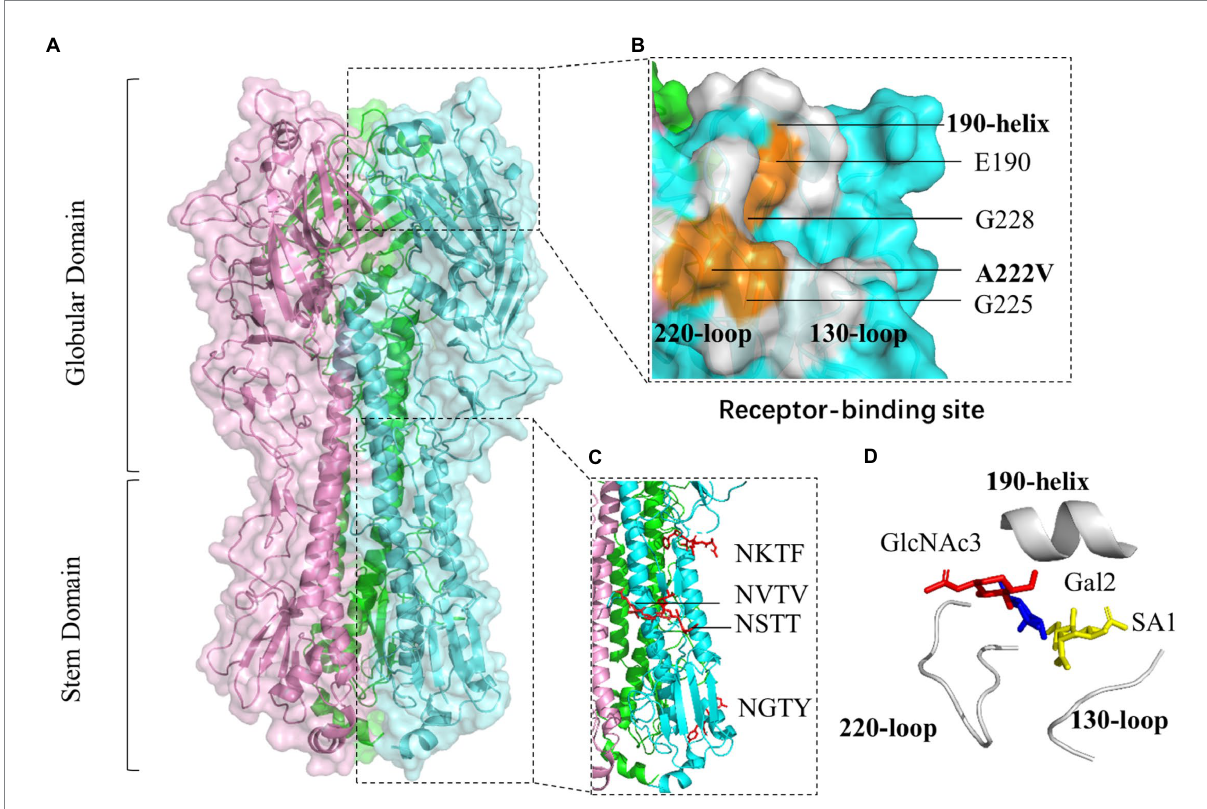
FIGURE 5 Molecular characterization of the H6N6-subtype AIVs. (A) The crystal structure of the ectodomain of haemagglutinin (HA) reveals two distinct domains: the globular domain and the stem domain. Each monomer is represented by pink, green, and blue, respectively. (B) Three secondary structural elements (in white color) and the sites associated with H6 receptor-binding properties (in orange color). (C) N-glycosylation sites (in red color). (D) The H6N6 HA receptor analogue ( α 2, 3-linked sialylated glycan receptor). Sialylated glycans of the host receptors that influenza viruses bind to contain the three-terminal saccharides: the terminal sialic acid SA1, the galactose ring Gal2 (at position two relative to SA), and N-acetylglucosamine GlcNAc3 (at position three relative to